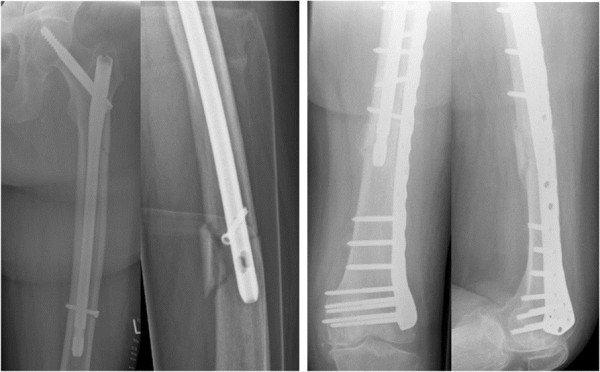
Patient with peri-osteosynthetic fracture: postoperatively, during follow-up and after revision with plate osteosynthesis.